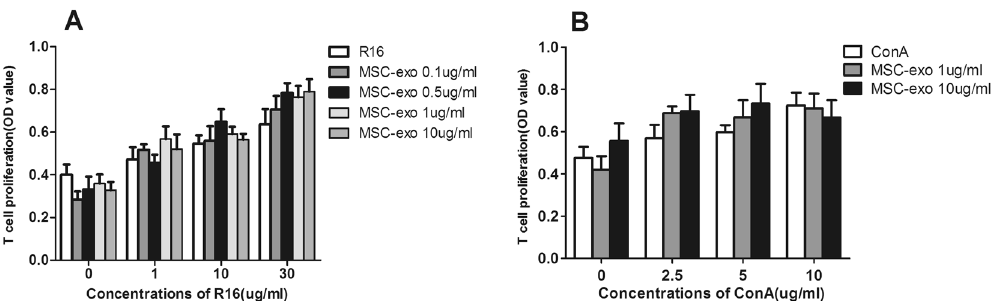
Figure 8. The effect of MSC-eso on T cell proliferation. T cells and APCs were prepared on day 12 after immunization, from lymph nodes and spleens of EAU rats, and were incubated (T cells/APCs, 1:1) for 48 hours with graded doses of R16 (0, 1, 10 and 30 μ g/ml) and MSC-Exo (0, 0.1, 0.5, 1 and 10 μ g/ml) ( A ), or with ConA (0, 2.5, 5, 10 μ g/ml) and MSC-Exo (1 and 10 μ g/ml). T cell proliferation was determined by measurement of BrdU incorporation. * P <